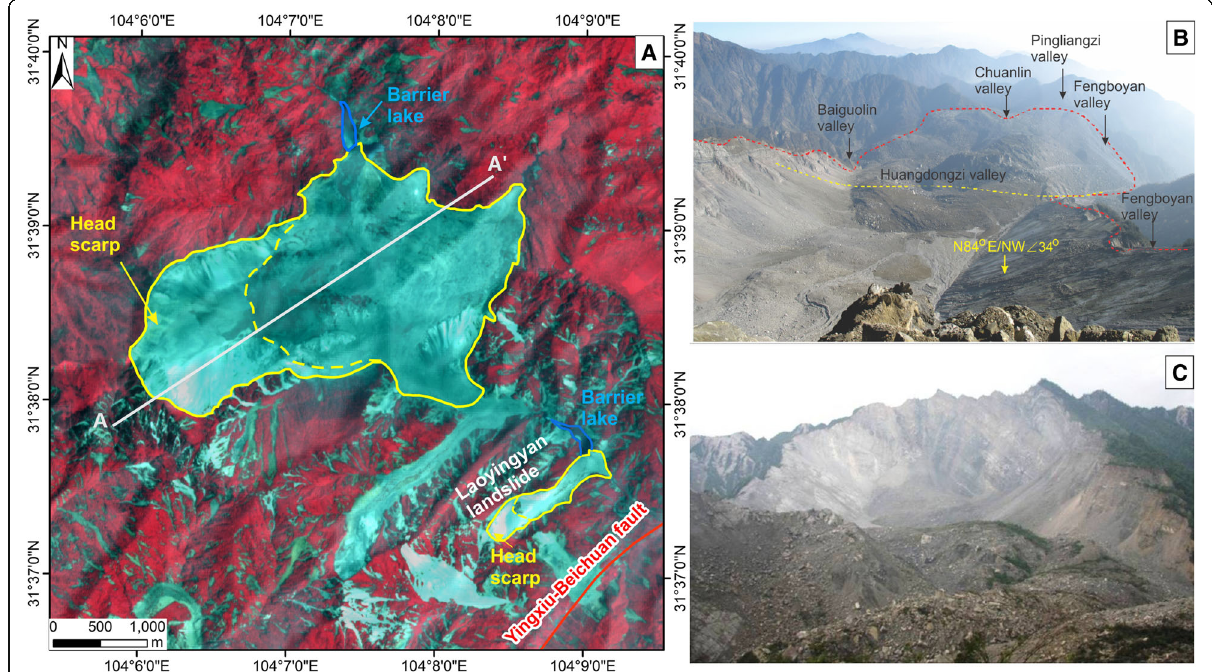
Fig. 3 Daguangbao landslide. a ALOS AVNIR image of the Daguangbao and the Laoyingyan landslide; b View from head scarp to the accumulation zone of the Daguangbao landslide; c Head scarp of the Daguangbao